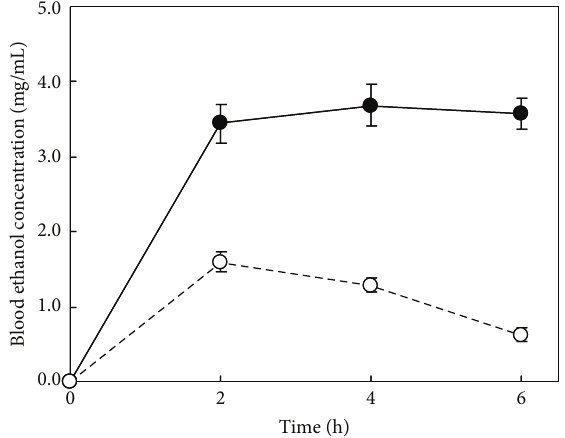
Figure 2: Changes in the blood ethanol concentration following the ingestion of 2.0 or 4.0 g/kg ethanol in preliminary experiments. Results are expressed as means and standard deviations. --- I ---, 2.0 g/kg ( 𝑛 = 10 ); — e —, 4.0 g/kg ( 𝑛 = 8